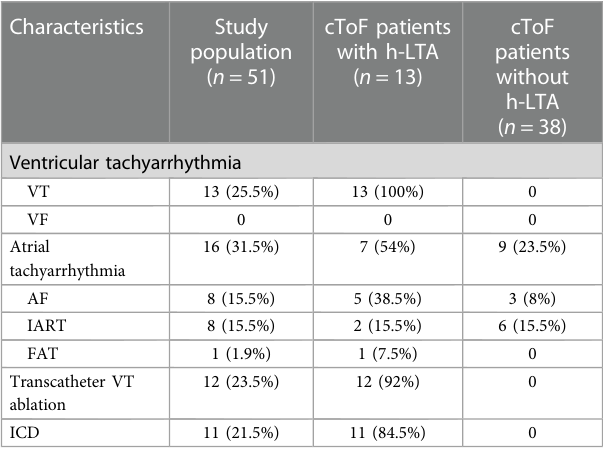
TABLE 1 Baseline characteristics of the study population. TABLE 2 Arrhythmia burden in patients with repaired Tetralogy of Fallot.